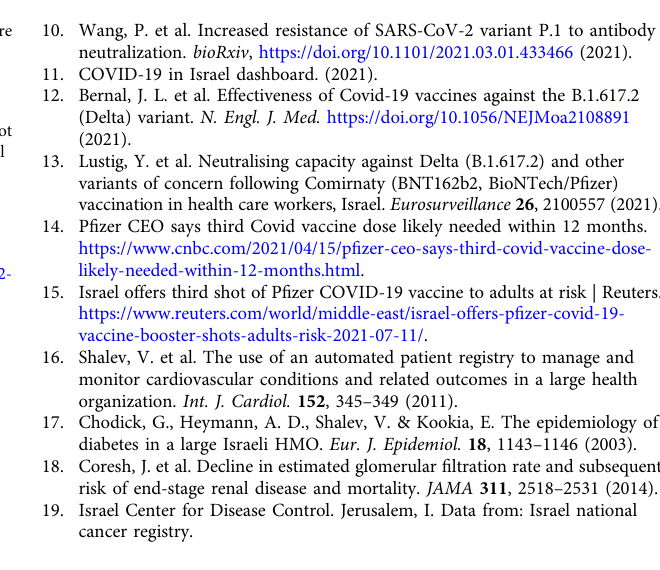
Fig. 2 Accumulative breakthorough infections and hospitalizations among Early and Late Vaccinnes during June - July 2021, Israel. Kaplan – Meier curves are used for the accumulative probability of breakthrough infection ( a ) and hospitalization ( b ) between June and July 2021 among individuals who were vaccinated Early (January to February 2021) compared with individuals who were vaccinated late (March to April 2021). X axis in curves a , b represents days from the start of the follow-up period (June 1, 2021). Shading illustrates 95% CIs ( a , b